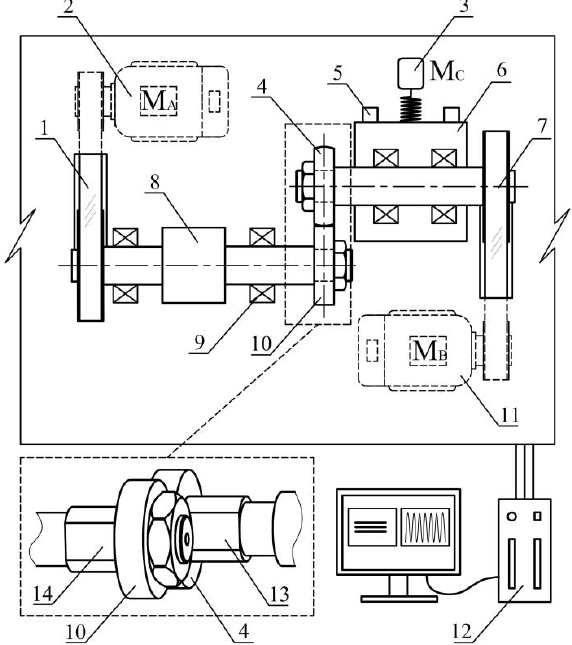
Figure 4. Rolling–sliding wear testing apparatus: 1—synchronous belt A; 2—servo motor A; 3—servo motor C; 4—wheel specimen; 5—linear guide; 6—load platform; 7—synchronous belt B; 8—torque sensor; 9—rolling bearing; 10—rail specimen; 11—servo motor B; 12—data acquisition and control system; 13—rotation axis B; 14—rotation axis